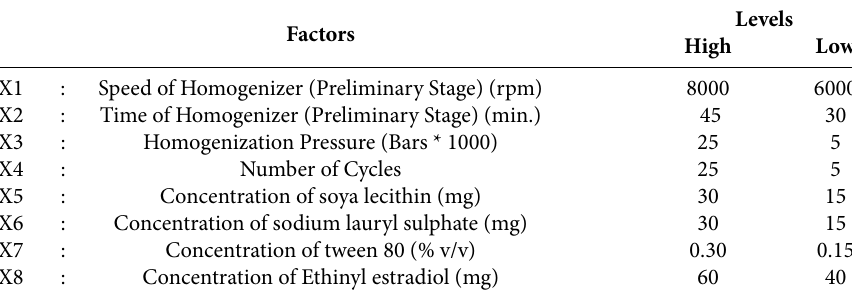
Table 2. Plackett–Burman design with independent variables and their responses.